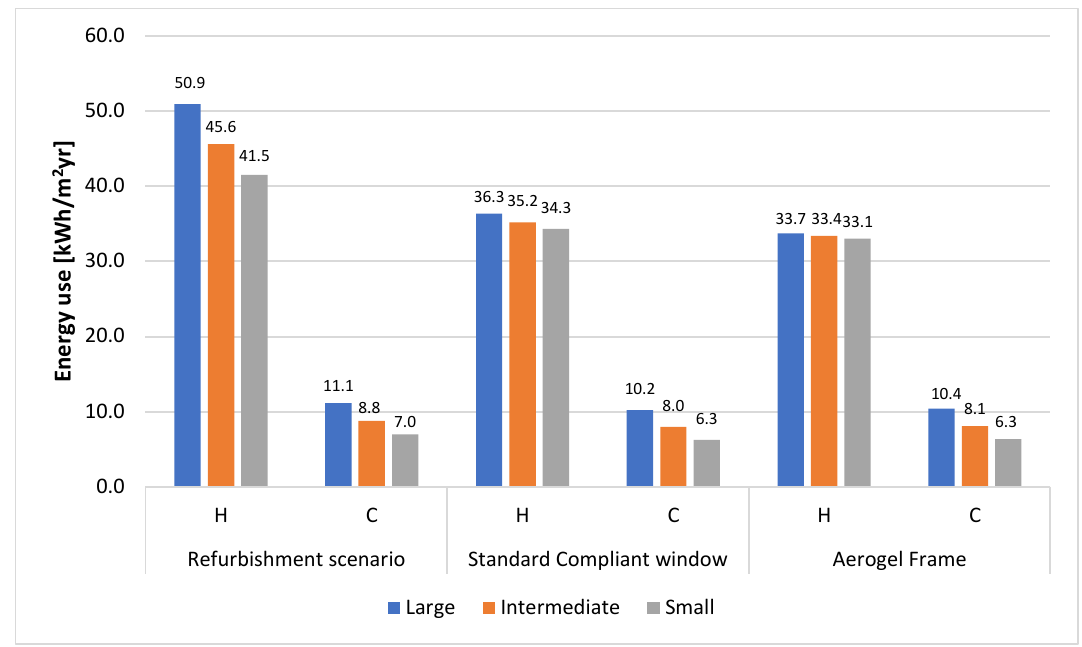
Figure 9. Energy use for heating and cooling using three di ff erent window sizes on the North-facing Figure 10. Energy use for heating and cooling using three different window sizes on the North-facing 343 exposure, in Toronto. (H = Heating, C = exposure, in Toronto. (H= Heating, C= Cooling). 344